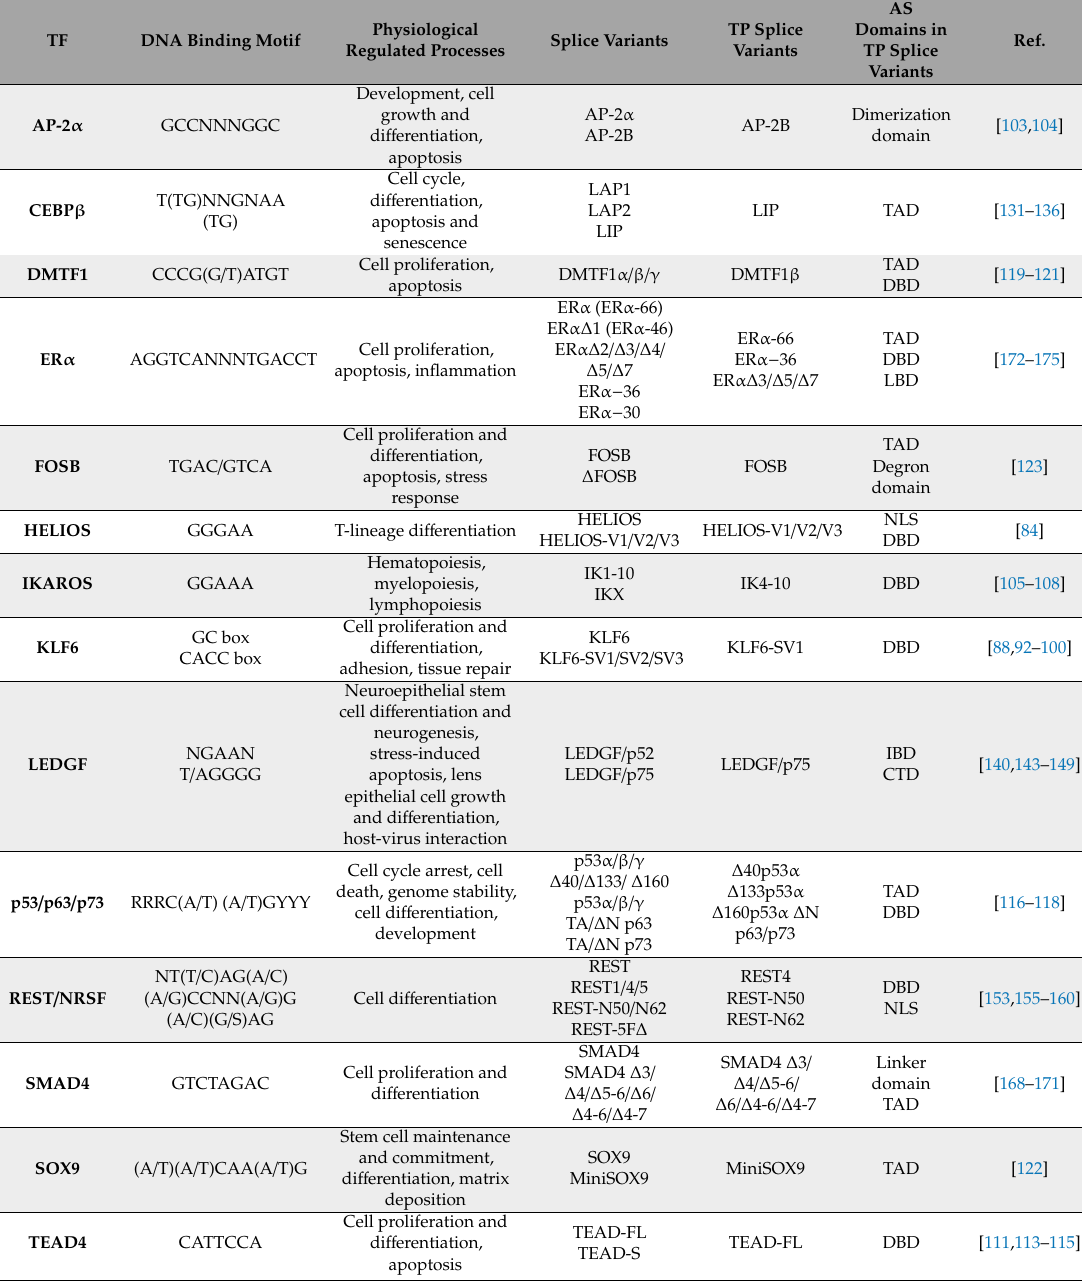
Table 3. Transcription factors (TFs) and respective splice variants expressed in tumor cells that function as dominant negative and hamper TF physiological activity. Tumor-promoting (TP) splice variants with clinical correlation data and relative AS domains have been listed. DBD (DNA binding domain), TAD (transactivation domain), NLS (nuclear localization signal), IBD (integrase binding